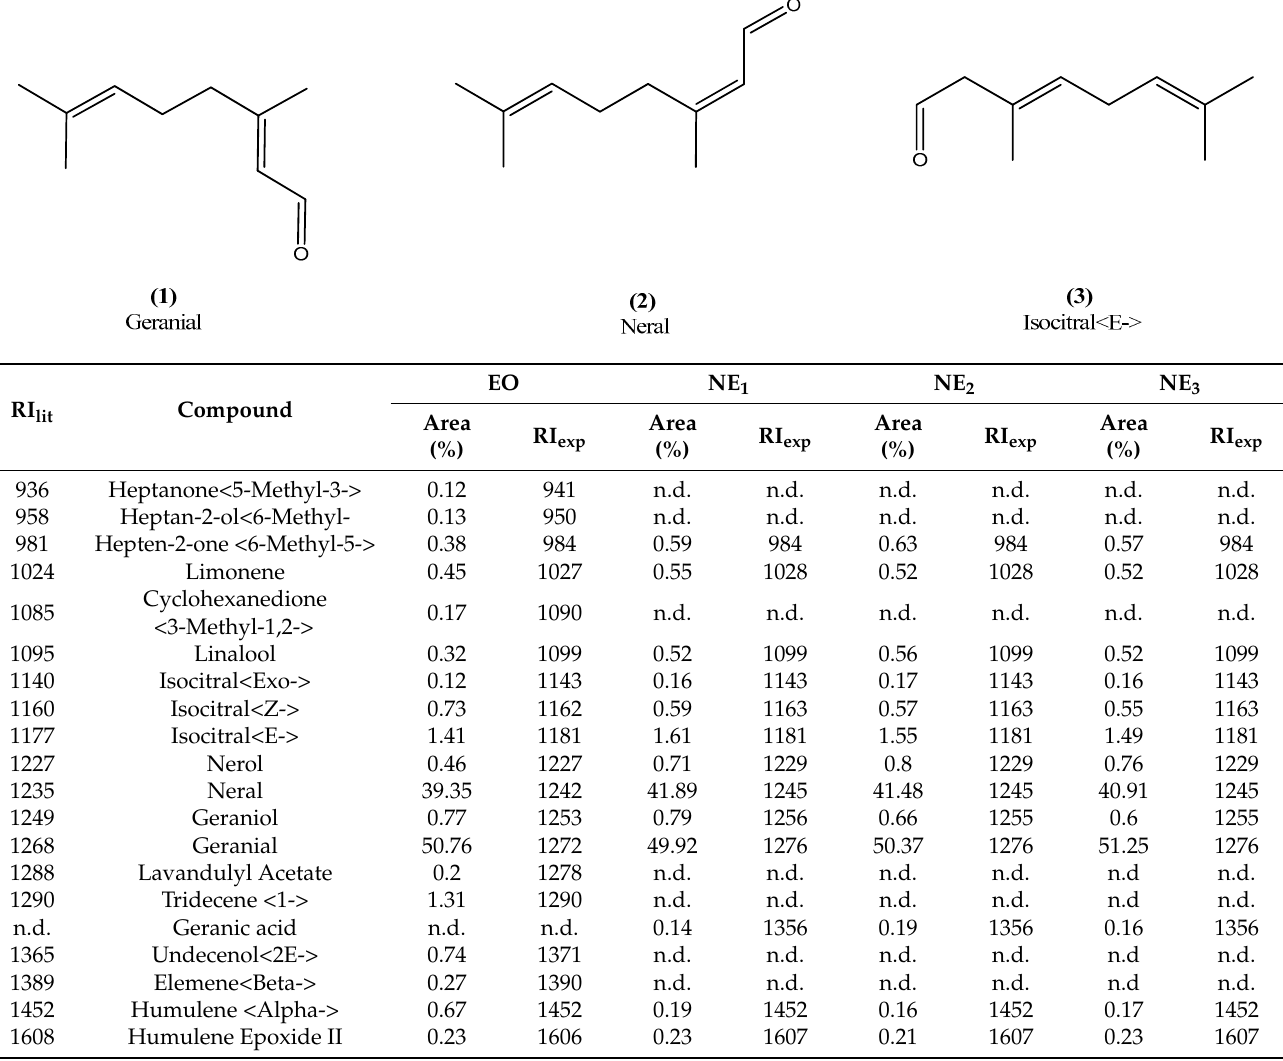
Table 1. Gas chromatograph analysis of the Pectis elongata essential oil (EO) before and after its nano-emulsification (NE1,2,3 = independent replicates). RI lit —retention index from the literature (Adams); RI exp —retention index (experimental); n.d.—not determined.